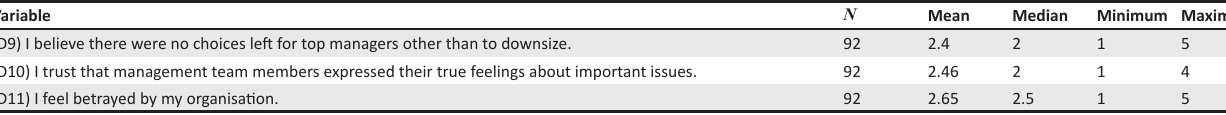
TABLE 4: Survivors’ perceptions of breaches of psychological contracts and trust in managers (section D). Variable